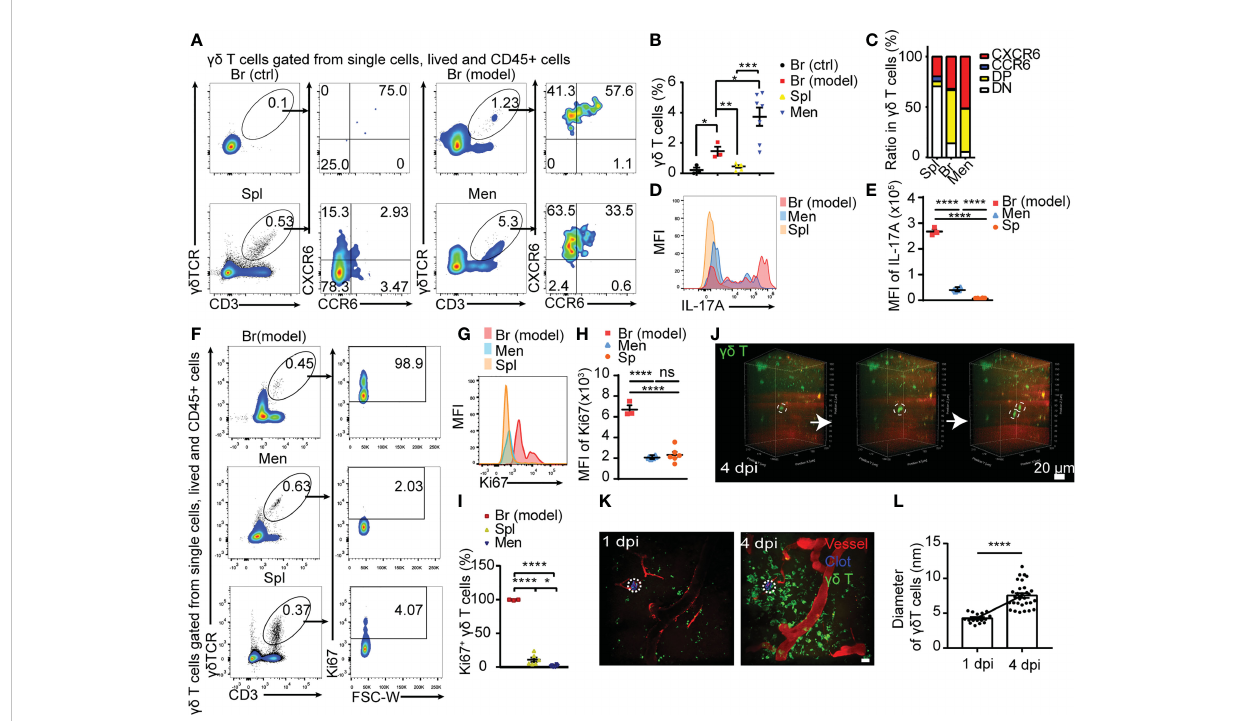
FIGURE 2 Meningeal gd T cells migrating to peri-CMBs brain parenchyma are activated to proliferate and secret IL-17A. (A) The properties of gd T cells sorted from peri-CMBs parenchyma (Br-model), contralateral cortex (Br-ctrl), meninges and spleen (Spl) of WT mice at 5 dpi are identi fi ed by fl ow cytometry. (B, C) Statistical analysis of fl ow cytometry shows that gd T cells are signi fi cantly increased in peri-CMBs parenchyma (B) ; one sample from 2-3 mice and n ≥ 3 samples in each group) and gd T cells of peri-CMBs parenchyma and meninges are characterized by the elevated expression of CXCR6 and CCR6 (C) ; DP: CCR6 and CXCR6 double positive; DN: double negative; * P <0.05; ** P <0.01; *** P <0.001; n=7, One-way ANOVA with Tukey ’ s multiple comparison). (D, E) High expression of IL-17A is identi fi ed in gd T cells of peri-CMBs parenchyma by measuring mean fl uorescence intensity (MFI) at 5 dpi (3 independent experiments in each group). (F – I) High expression of Ki67 is identi fi ed in parenchymal gd T cells at 5 dpi using fl ow cytometry. The percentages of Ki67-positive gd T cells derived from different tissues (F) , mean fl uorescence intensity of Ki67 expression (G,